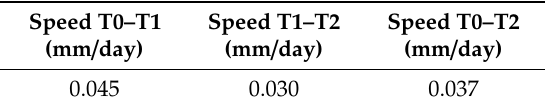
Table 7. Mean speed calculated in mm / day in every ranges of time considered (T0–T1: CT—2 months;